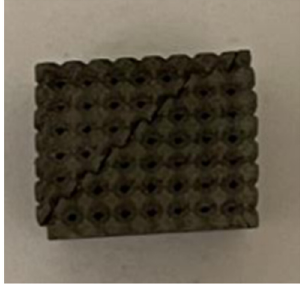
Figure 17: Sample after compression